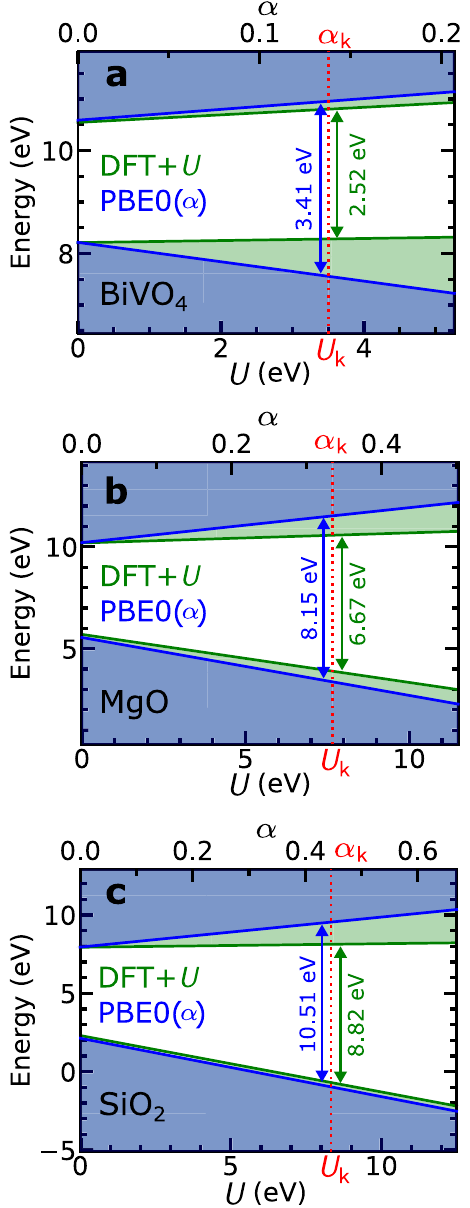
Fig. 2 Band gaps obtained with various functionals. Band edges as obtained with DFT + U and PBE0( α ) as a function of U and α , respectively, for BiVO 4 , MgO, and α -SiO 2 . For MgO, we consider U k and α k calculated for the self-trapped hole. The vertical red line denotes the choice of the parameter for which the piecewise linearity condition is retrieved. The energy levels are aligned with respect to the average electrostatic potential 98